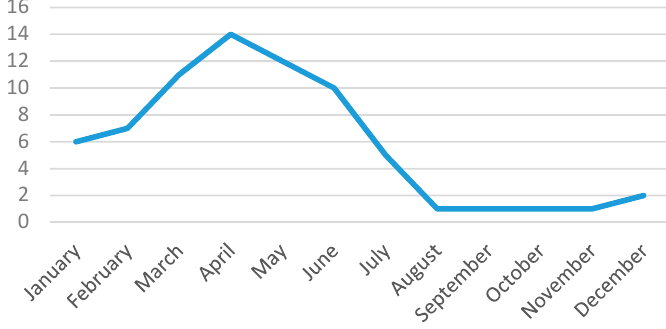
Figure 1. Monthly incidence of hospitalized varicella skin complications.